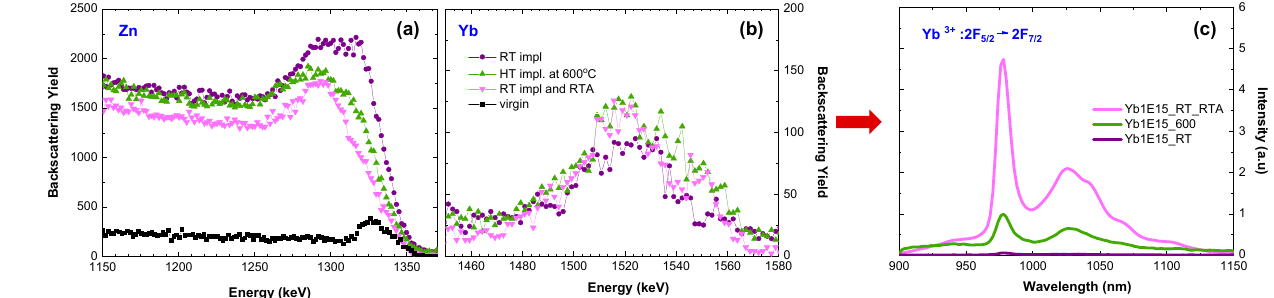
Figure 8. Aligned RBS spectra ( a , b ) obtained for ZnO implanted with 150 keV Yb ions to the fluence 358